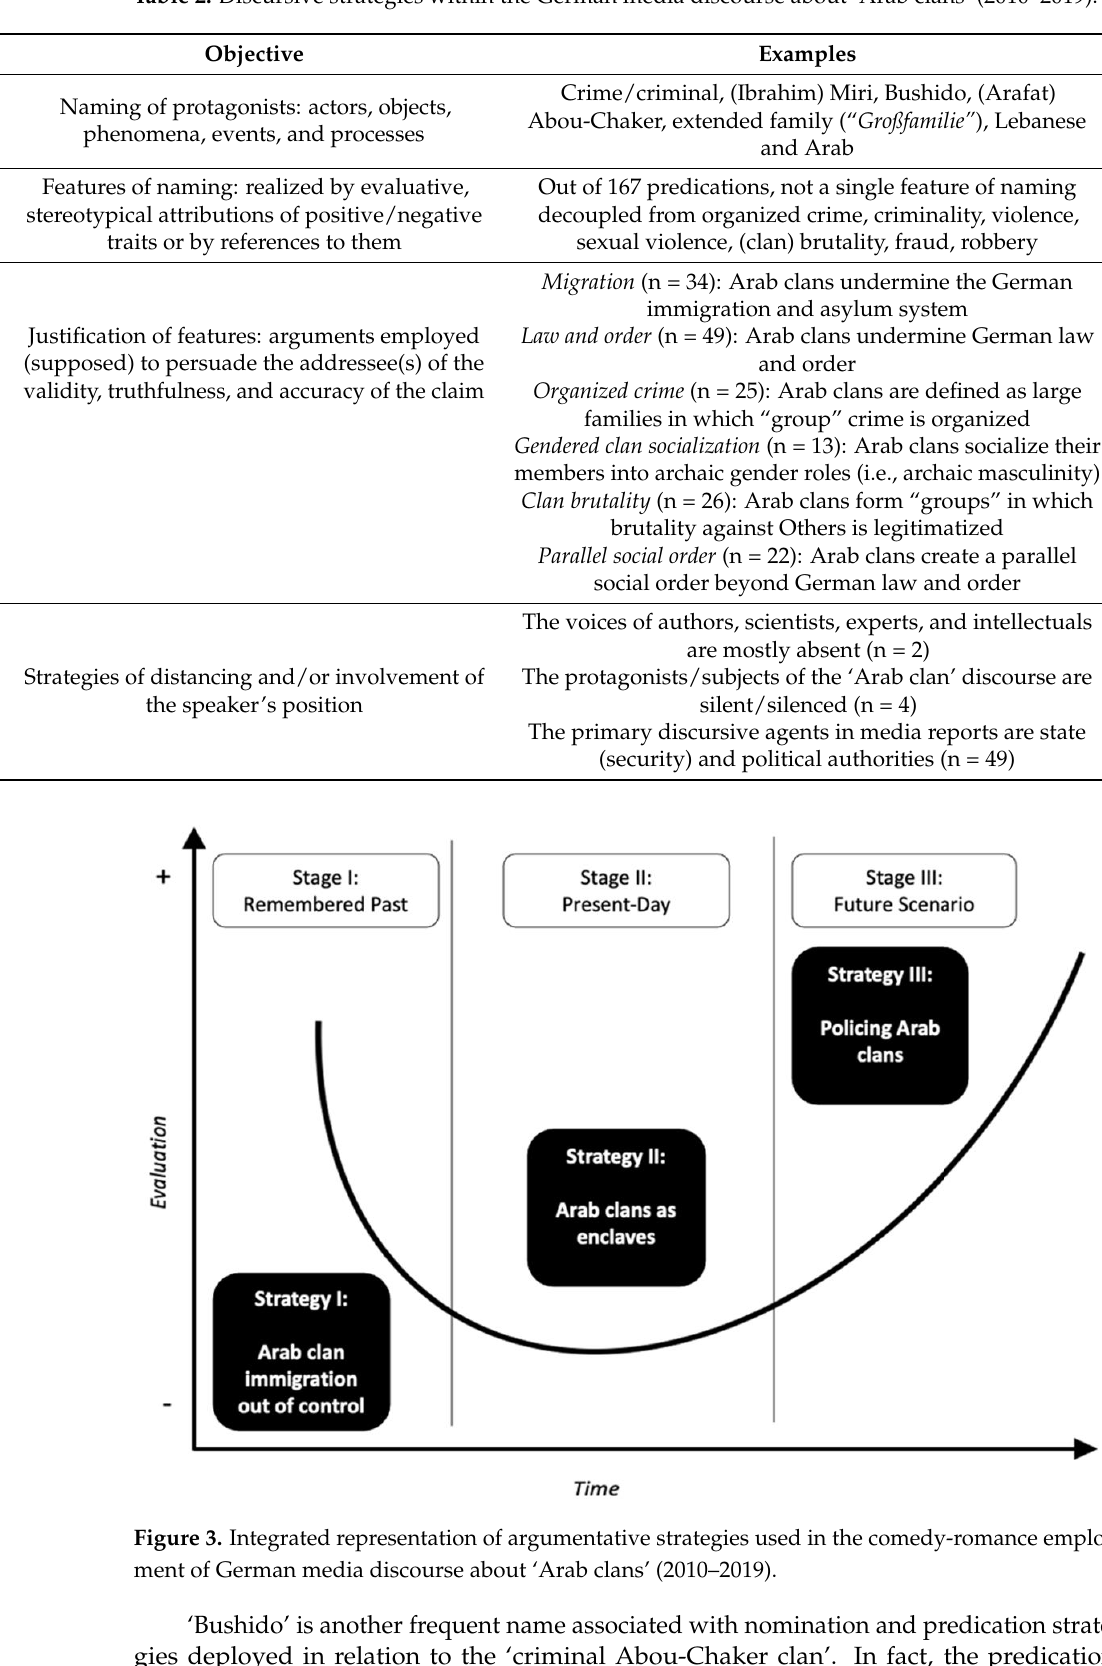
Table 2. Discursive strategies within the German media discourse about ‘Arab clans’ (2010–2019).